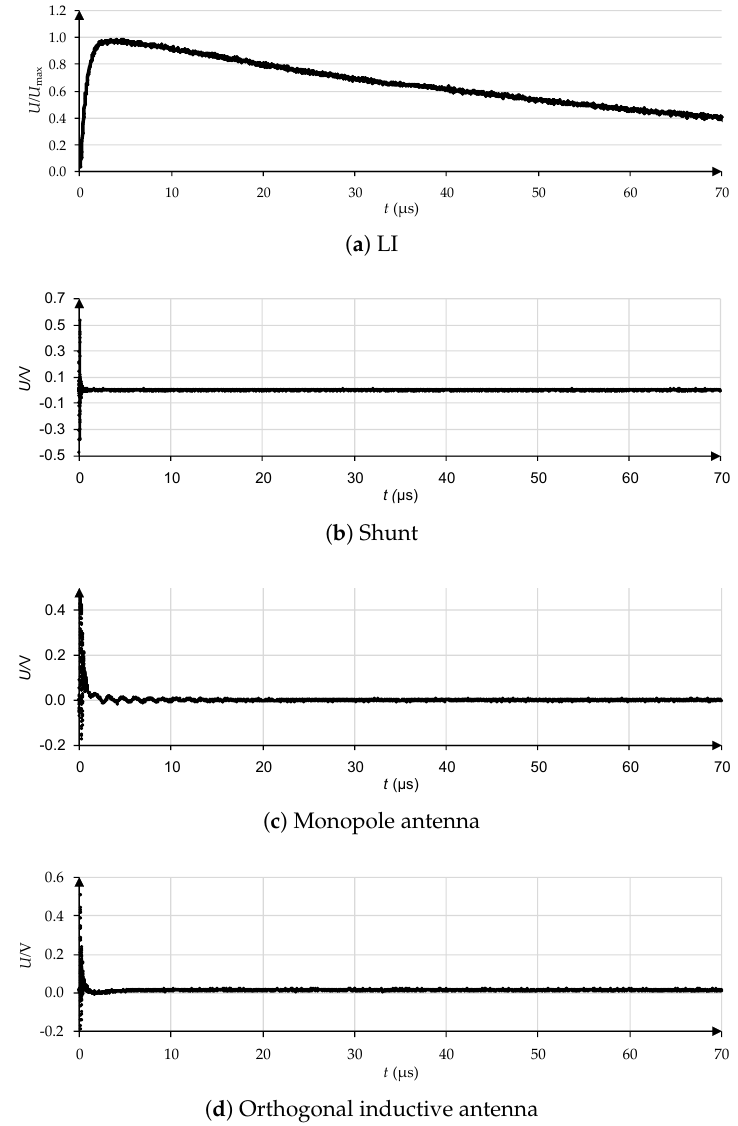
Figure 5. System response of the different sensors to an